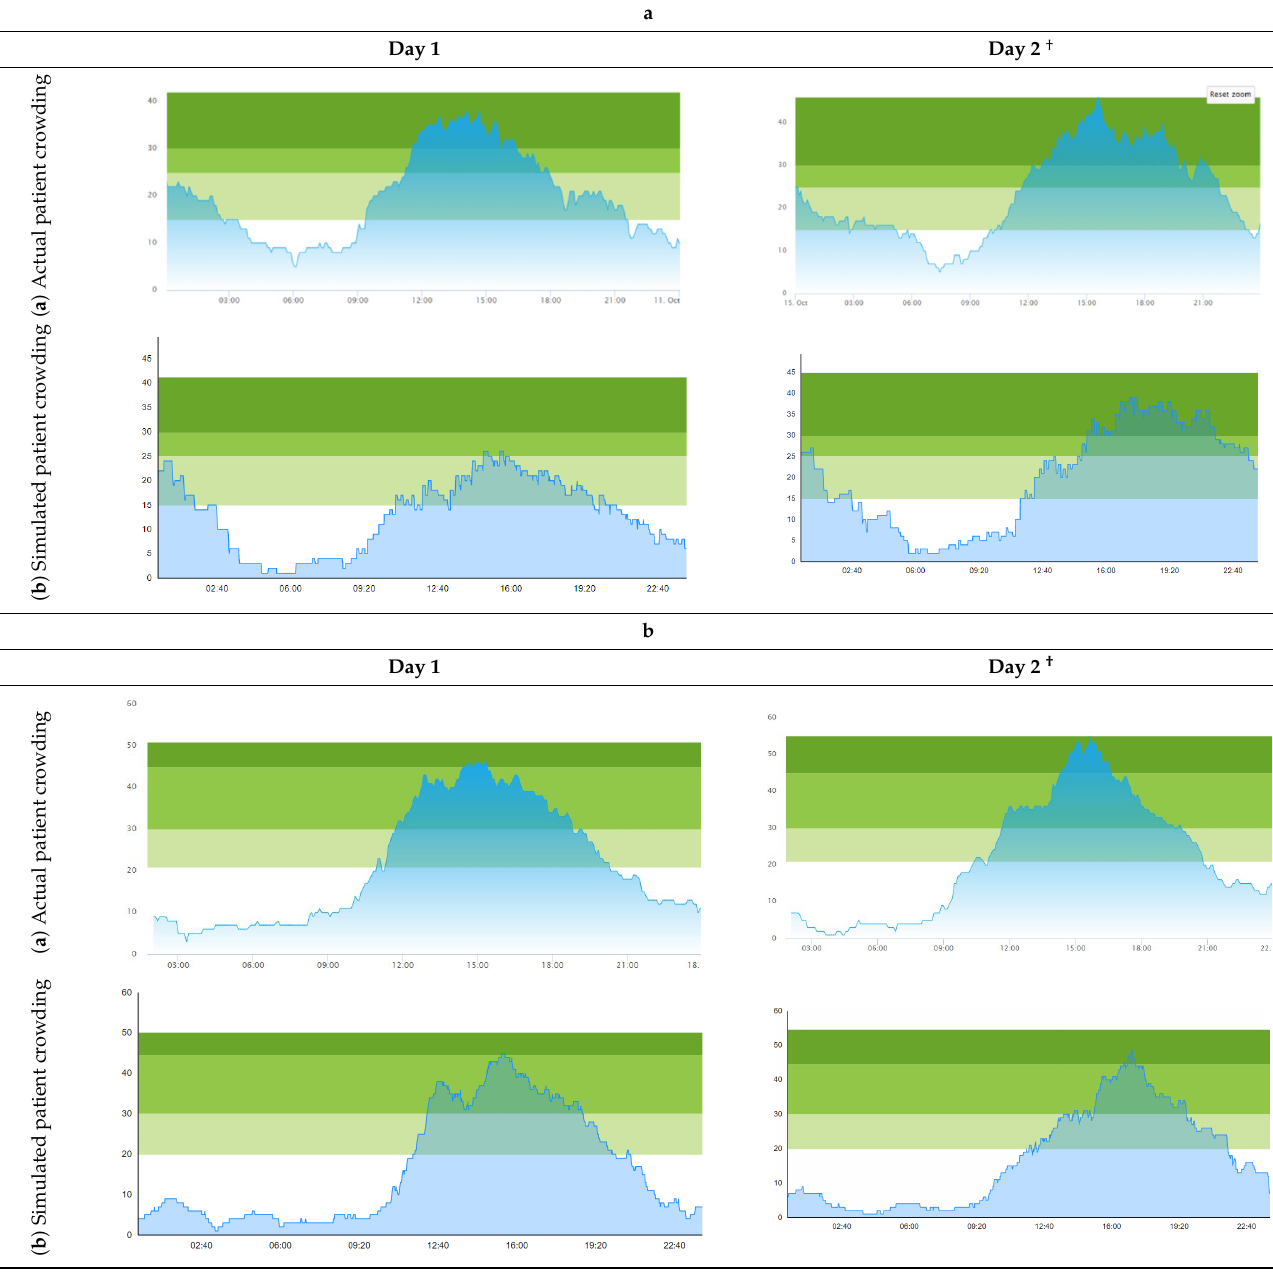
Figure 16. Snapshot of simulated KPI of patient flow in a pre-pandemic setting. Table 3. a. Model output validation comparing graphs of patient crowding in the ED in a pre-pan- demic situation. ( a ) Actual patient crowding data gathered from SmartCrowding, ( b ) Simulated pa- tient crowding. b. Model output validation comparing graphs of patient crowding in the ED in a peri-pandemic situation. ( a ) Actual patient crowding data gathered from SmartCrowding, ( b ) Sim- ulated patient crowding.